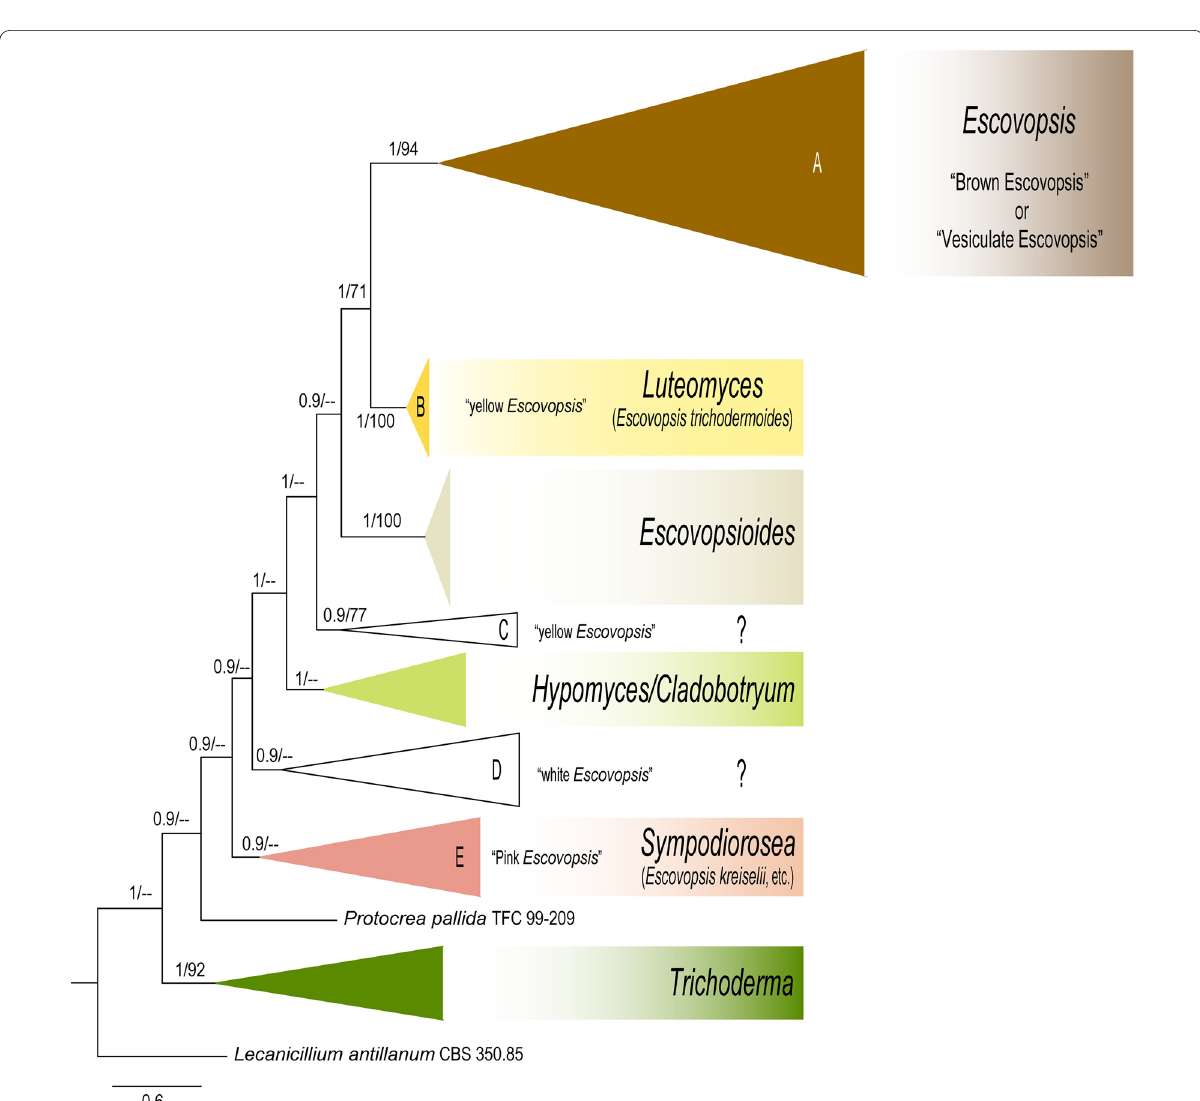
Fig. 1 Collapsed phylogenetic tree (from Additional file 3: Fig. S2) indicating the placement of every isolate previously treated as Escovopsis . The tree shown was inferred using Bayesian Inference (BI). The tree gathers all available tef 1 sequences found in the literature with the data set used in this study, including the sequences of the nine Escovopsis ex-type cultures. The tree contains a total of 440 sequences which include: 274 strains of vesiculate- Escovopsis (Clade A), 105 strains of non-vesiculate Escovopsis (Clades B, C, D, E) and 60 strains from four genera, i.e., Escovopsioides , Hypomyces (along with species under its anamorphic genus Cladobotryum ), Protocrea , and Trichoderma in the Hypocreaceae . Lecanicillium antillanum CBS 350.85 is used as the outgroup of the tree (see Additional file 1: Table S3 for all strains and their associated metadata used to infer this phylogenetic tree). There is only information, in the literature, on the colour of the colonies of the clades C and D, but the microscopic features of these clades are unknown. Numbers on branches indicate BI posterior probabilities (PP) and Maximum Likelihood bootstrap support values (MLB), respectively. Hyphens (--) indicate MLB <